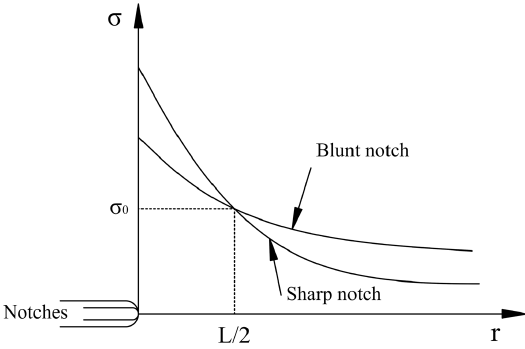
Figure 3. Linear–elastic stress versus distance curve for notches with different